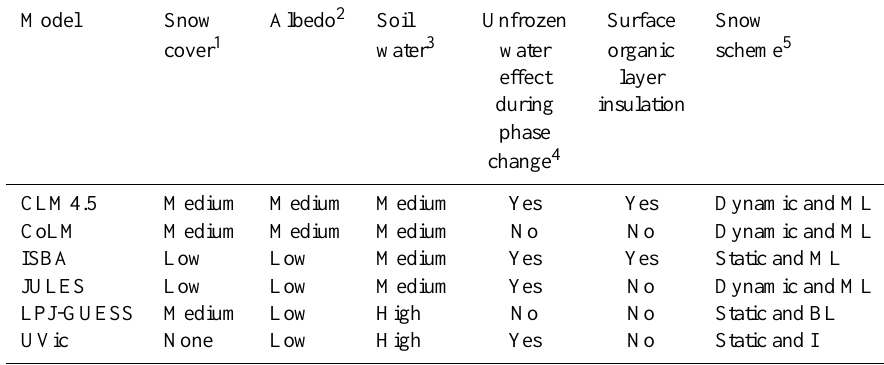
Table 5. Description of model characteristics relevant to soil temperatures on the TP. Model